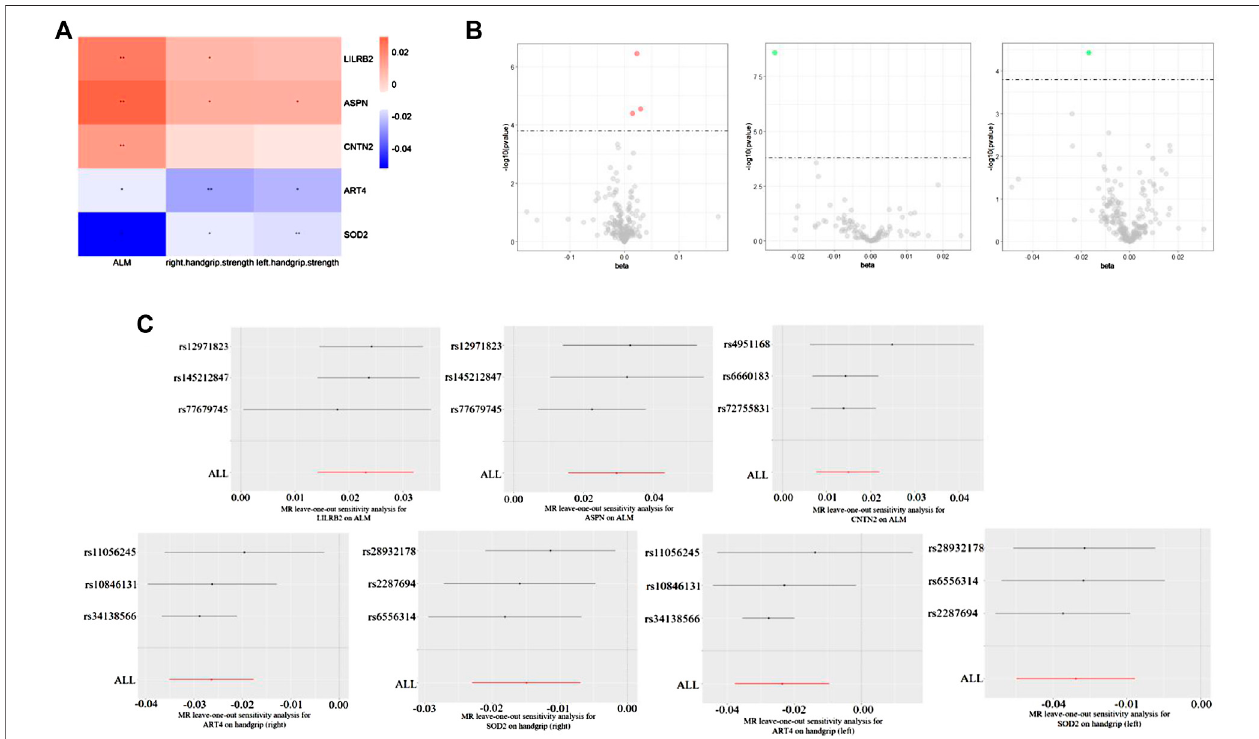
FIGURE 1 | (A) Heat map of Sarcopenia-related traits (rows) and the fi ve plasma proteins (columns). The colour scale runs from blue (negative correlation) to red (positive correlation). Note: *, p < 0.05, **, p < 0.05/310. (B) Volcano maps of Sarcopenia-related traits and the fi ve plasma proteins. (C) MR leave-one-out sensitivity analysis for the fi ve plasma proteins on ALM and handgrip (left and